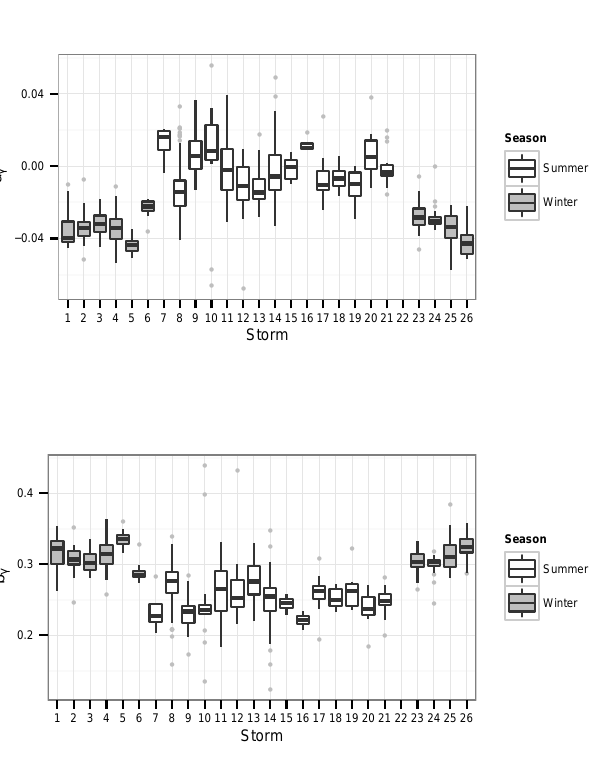
Figure 17. The parameter for the mean of the increment, shown as boxplots for each storm. Summer storms clearly have lower increments.